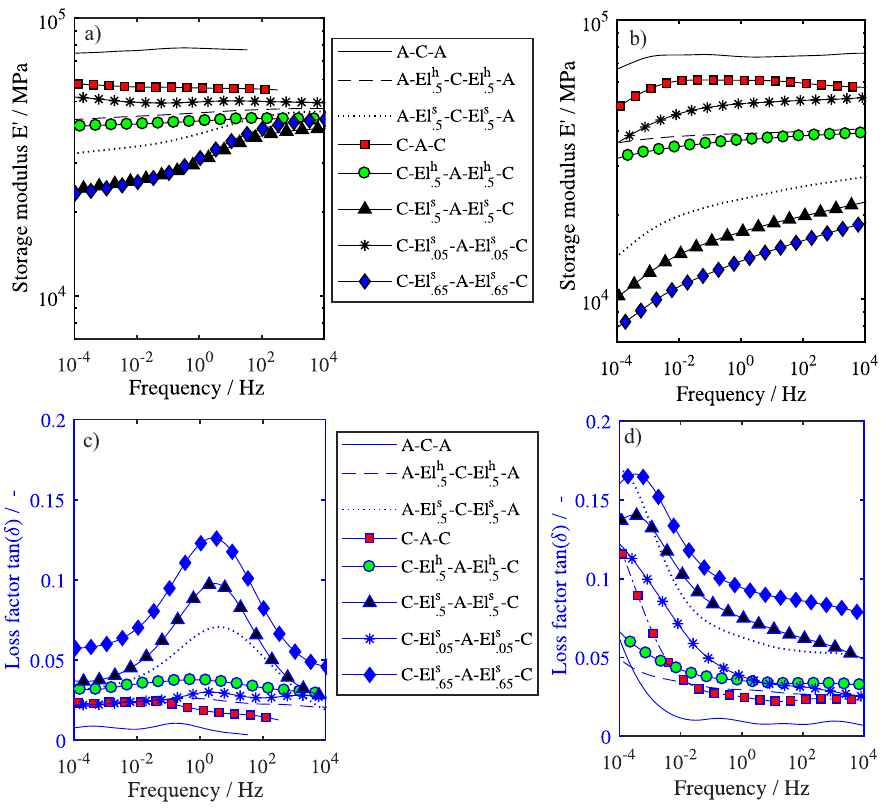
Figure 10. Master curves for all specimens at T Ref = − 40 ◦ C ( a , c ) and T Ref = 80 ◦ C ( b , d ). For better visibility, fewer markers are displayed for the fitted